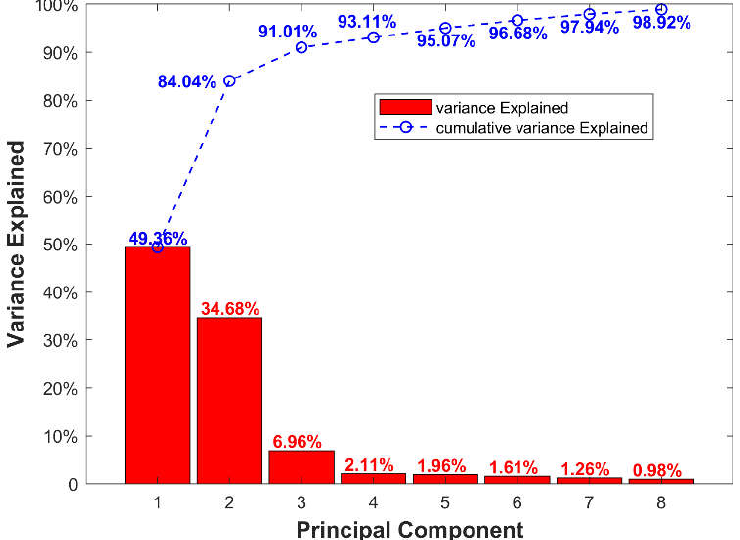
Figure 5. Schematic representation of the variance explained of principal component analysis.